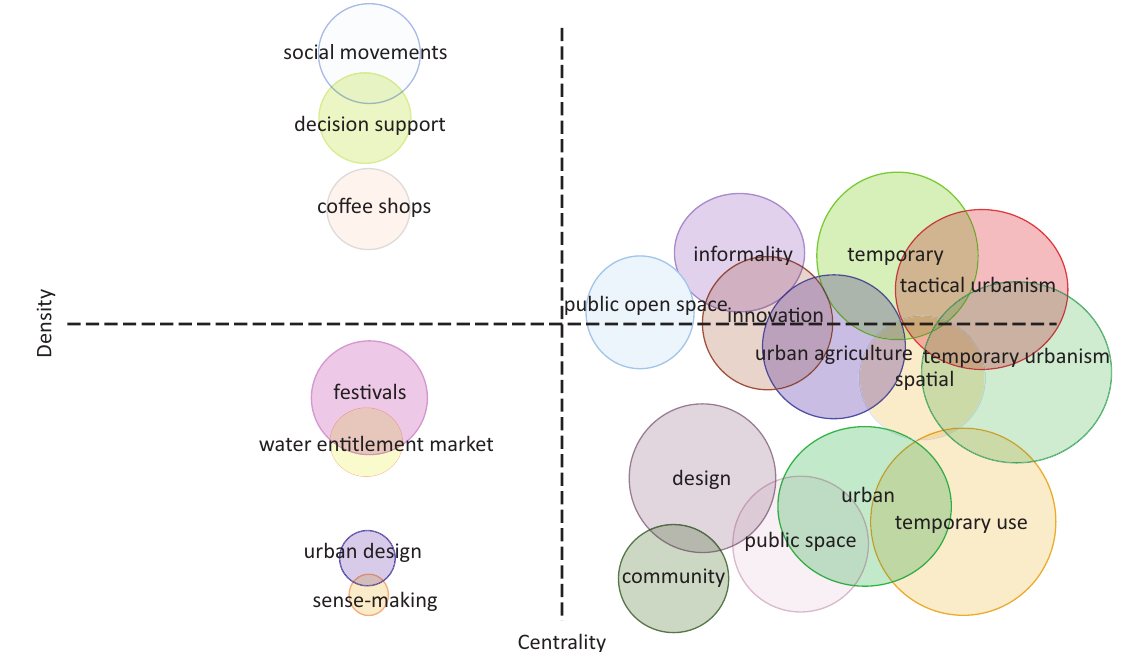
Figure 7. Thematic map of the 500 most common co-occurring keyword. Notes: Clustering and sizes are in relation the proportion of most common co-occurring words. Location determined by the Callon measure of density and